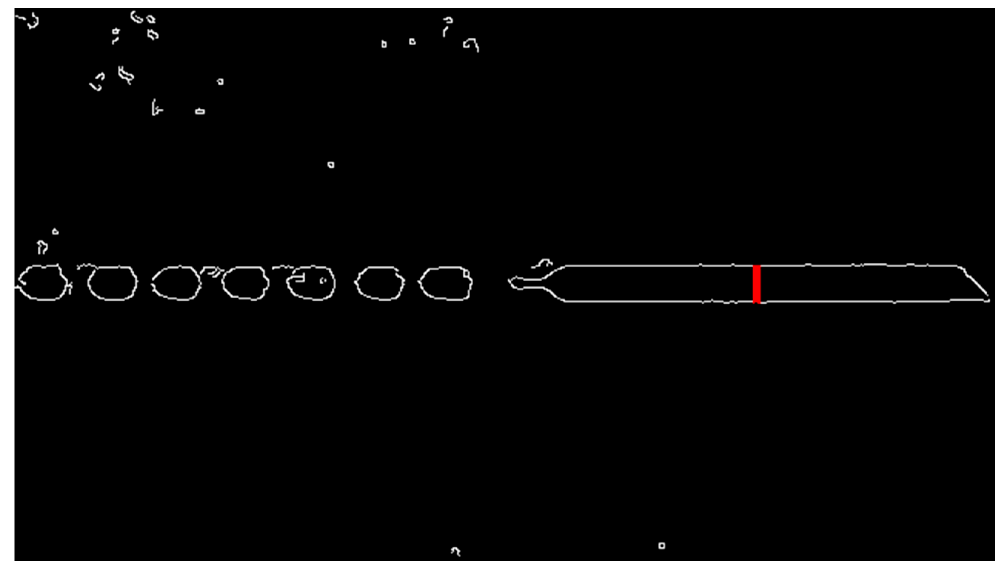
Figure 10. The image edges to find the scale factor.